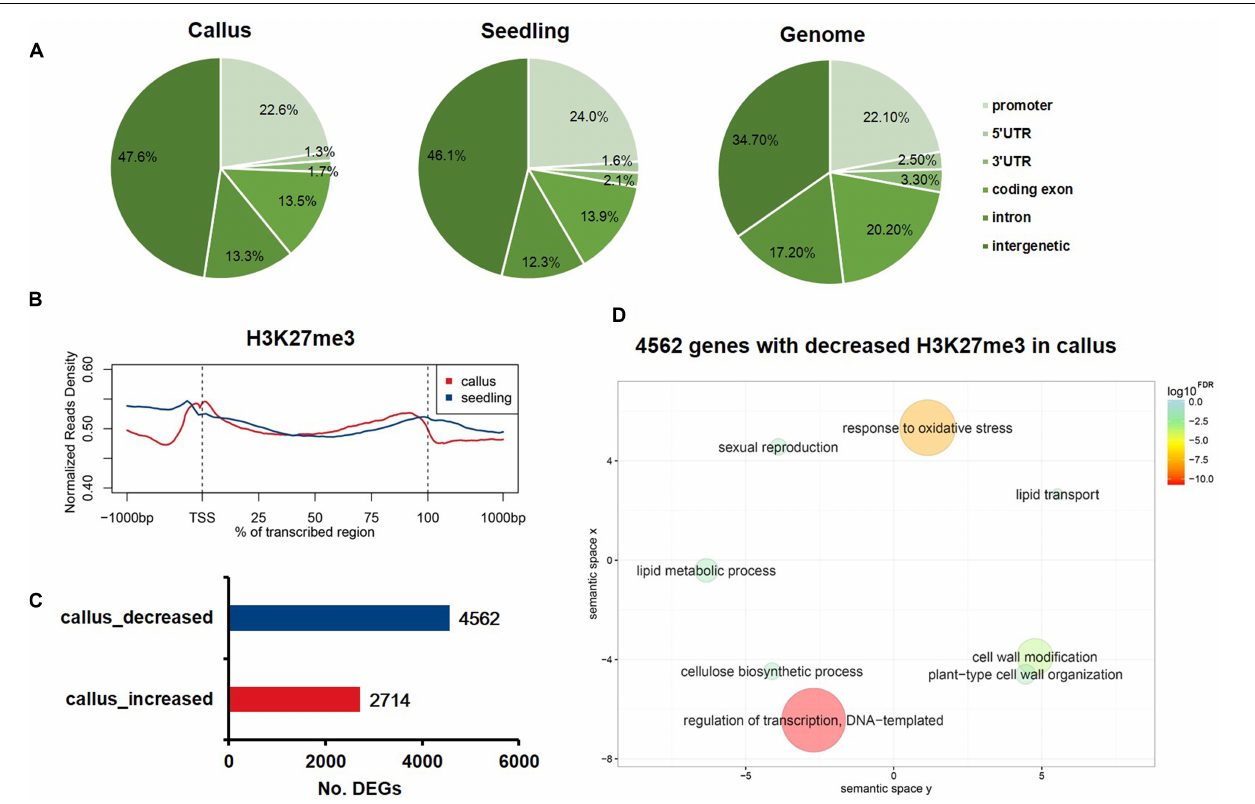
FIGURE 1 | The characteristics of H3K27me3 in rice callus and seedling tissue. (A) The genomic distribution of H3K27me3 peaks within different regions in rice callus and seedling tissues. The rice genome was characterized into six classes that included five genic regions [promoter, 5 (cid:48) untranslated region (UTR), 3 (cid:48) UTR, coding exon, and intron] and intergenic regions. (B) The distribution of H3K27me3 along all the rice genes in the callus and seedling (from 1-kb upstream regions to 1-kb downstream regions). (C) The number of genes with differential deposition of H3K27me3 between callus and seedling. (D) GO enrichment analysis of 4,562 H3K27me3-decreased genes in callus by agriGO and REVIGO. The scatterplot shows the cluster representatives in a two-dimensional space derived by applying multidimensional scaling to a matrix of significant GO terms with semantic similarities. Bubble color and size indicate the log10 FDR .